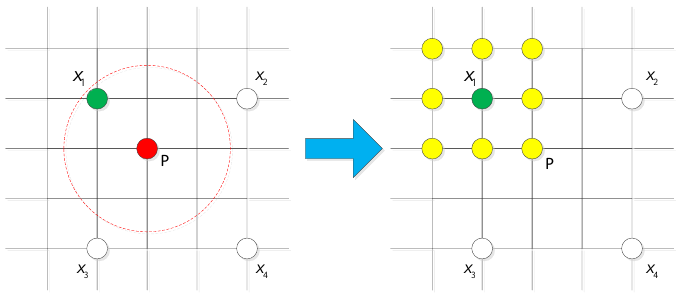
Figure 7. The sparse grid detection strategy. We begin by evaluate only a sparse grid ( x 1 , x 2 , x 3 , x 4 ). Suppose P is a peak score window and its ROS is represented by the red dash line circle. Window x 1 is in the ROS, thus it will passes k stages of the BDT cascade and every window in its 3 × 3 neighbourhood is triggered (yellow